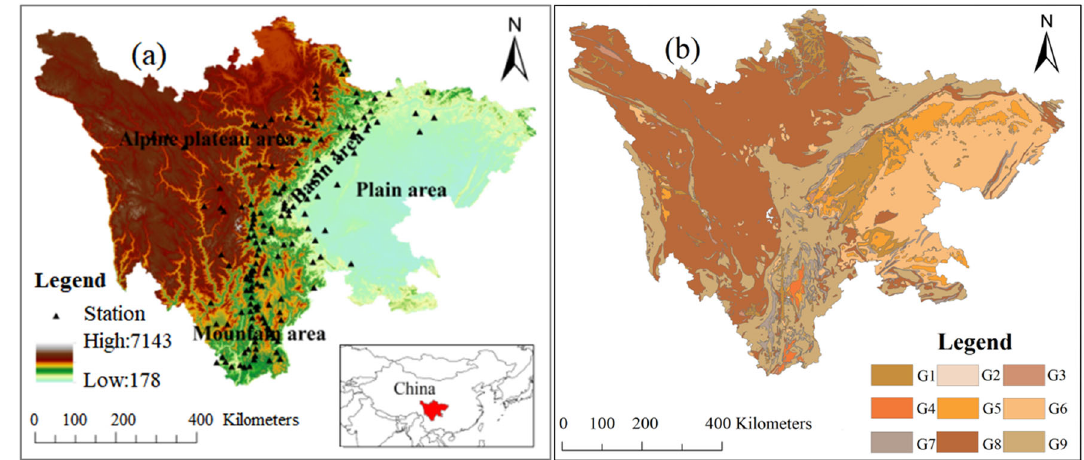
Fig. 1 Basic land surface and subterranean units of Sichuan Province: a geographical overview of Sichuan Province, China; and b geological composition in Sichuan Province based on the 1:500,000 scale geological map. G1: Holocene sandy and clayey alluvial deposits; G2: Neogene sedimentary rocks; G3: